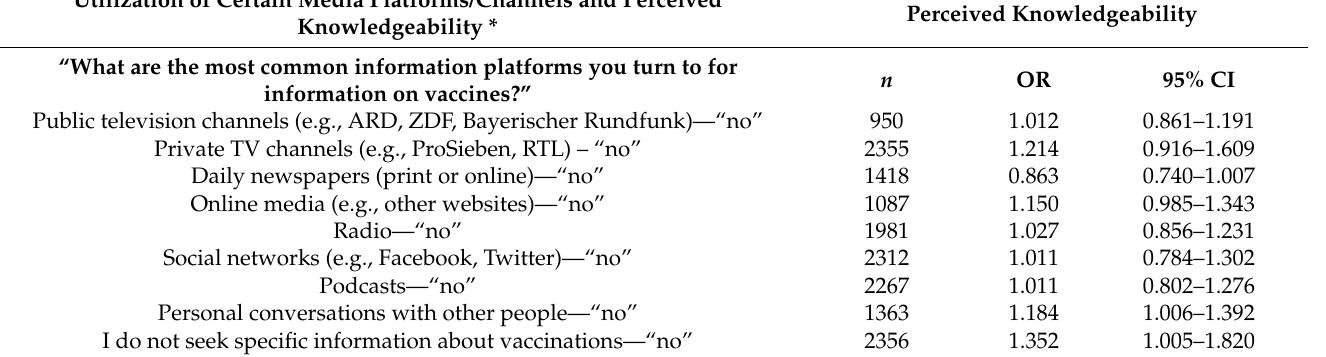
Table 9. Generalized linear models for the utilization of certain media platforms/channels associated with the perceived knowledgeability regarding COVID-19